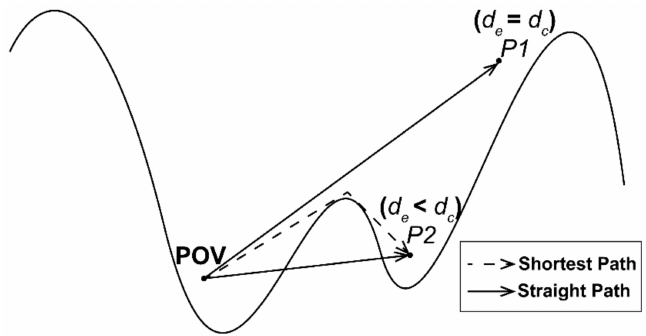
Figure 9. Calculation of visibility by comparing the shortest distance and the Euclidean distance from a point of view (POV) to target points.